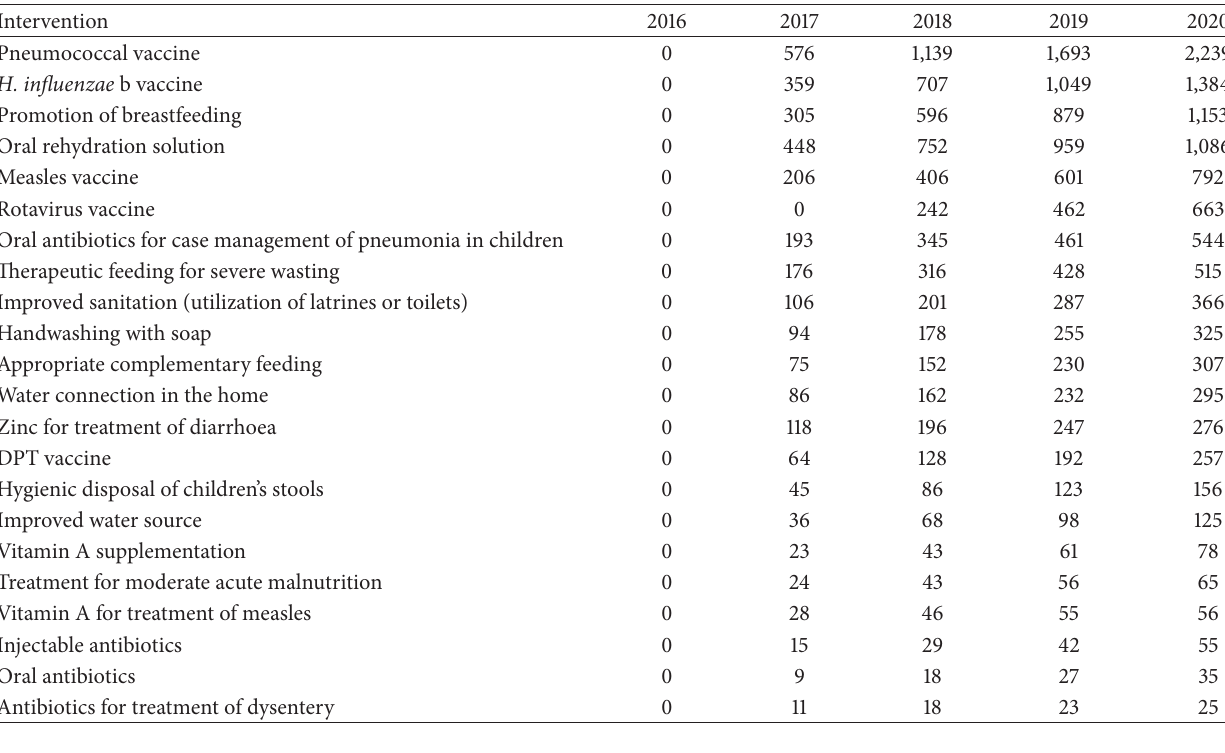
Table 2: Additional deaths prevented in children under five years of age by intervention by year.